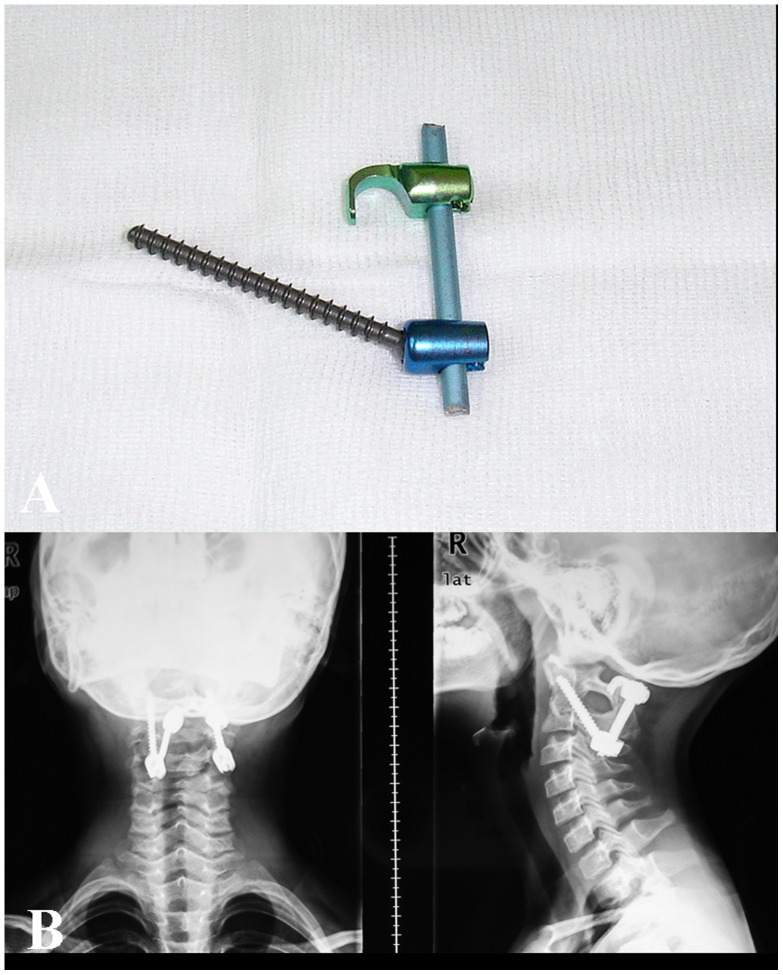
A modified implant and postoperative radiograph of patient 1.A color photograph (A) showing C1-2 transarticular hooks and C1 laminar hooks implant. Postoperative lateral and anteroposterior view radiographs (B) demonstrating the satisfactory position of implants.